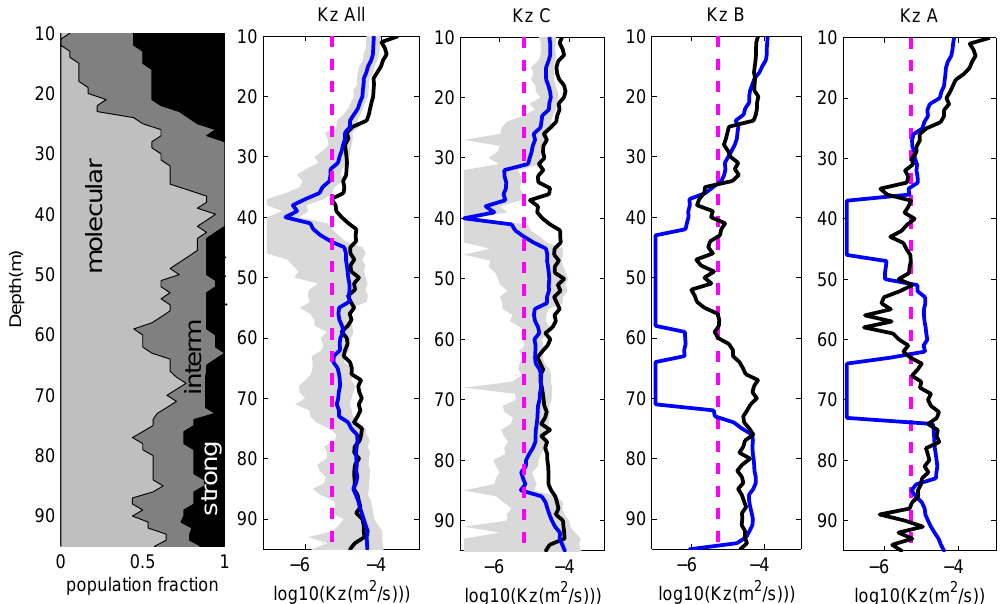
Fig. 9. Panel 1: proportion of the various diffusion regimes (strong, intermediate, molecular) found from SCAMP dissipation measurements. Figure 9: Panel 1 proportion of the various di(cid:27)usion regimes (strong, intermediate, molecu- Panel 2, 3, 4, 5: overall and station averaged profiles of K z from SCAMP in blue plain line with 95% confidence intervals in gray shading, lar) found from SCAMP dissipation measurements. Panel 2,3,4,5 overall and station averaged parameterization in black, and reference GM level in magenta dashed pro(cid:28)les of K z from SCAMP in blue plain line with 95 % con(cid:28)dence intervals in gray shading, parameterization in black, and reference GM level in magenta dashed lines